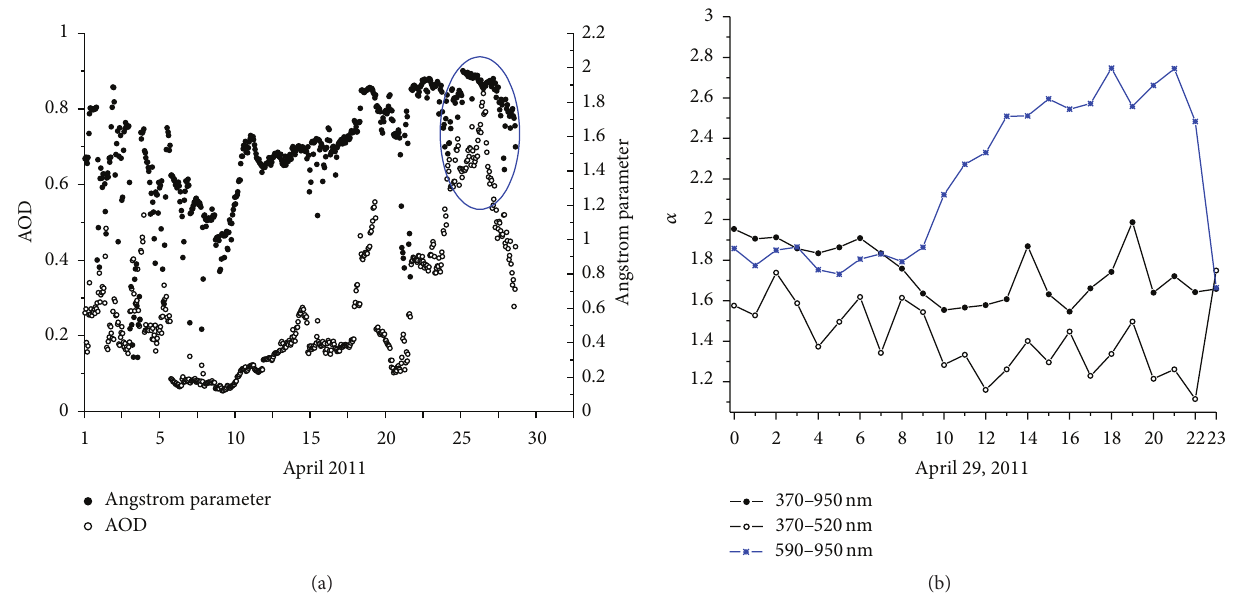
Figure 3: (a) The spectral variation of instantaneous measurements of AOD for April 2011 showing the gradual buildup and decline of smoke concentrations in this period (April 25–29, blue cycle); (b) values of the Angstr¨om exponent of the absorption coefficient (April 29, 2011) showing dynamic variations as a result of both increasing (decreasing) AOD and BC concentration and greater domination of fine mode versus coarse mode optical